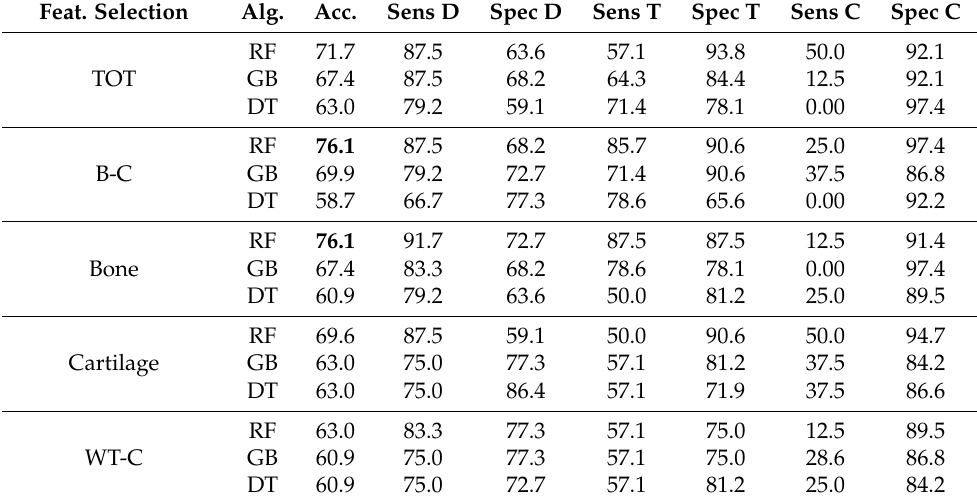
Table 4. Classification metrics for the three-class classification (degenerative (D), traumatic (T), control (C)) using the five different feature selections.